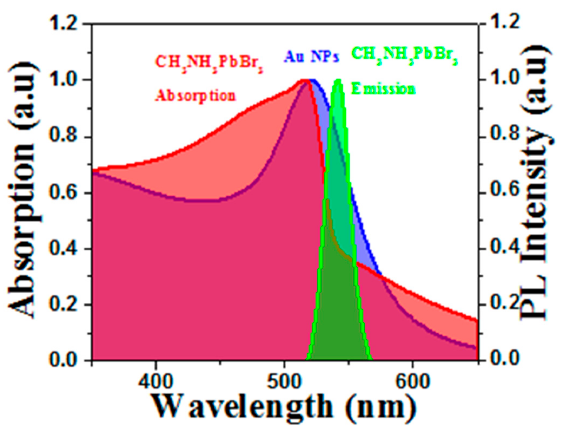
Figure 3. Absorption spectra of MAPbBr 3 film and Au NPs aqueous solution, PL spectrum of MAPbBr 3 film.